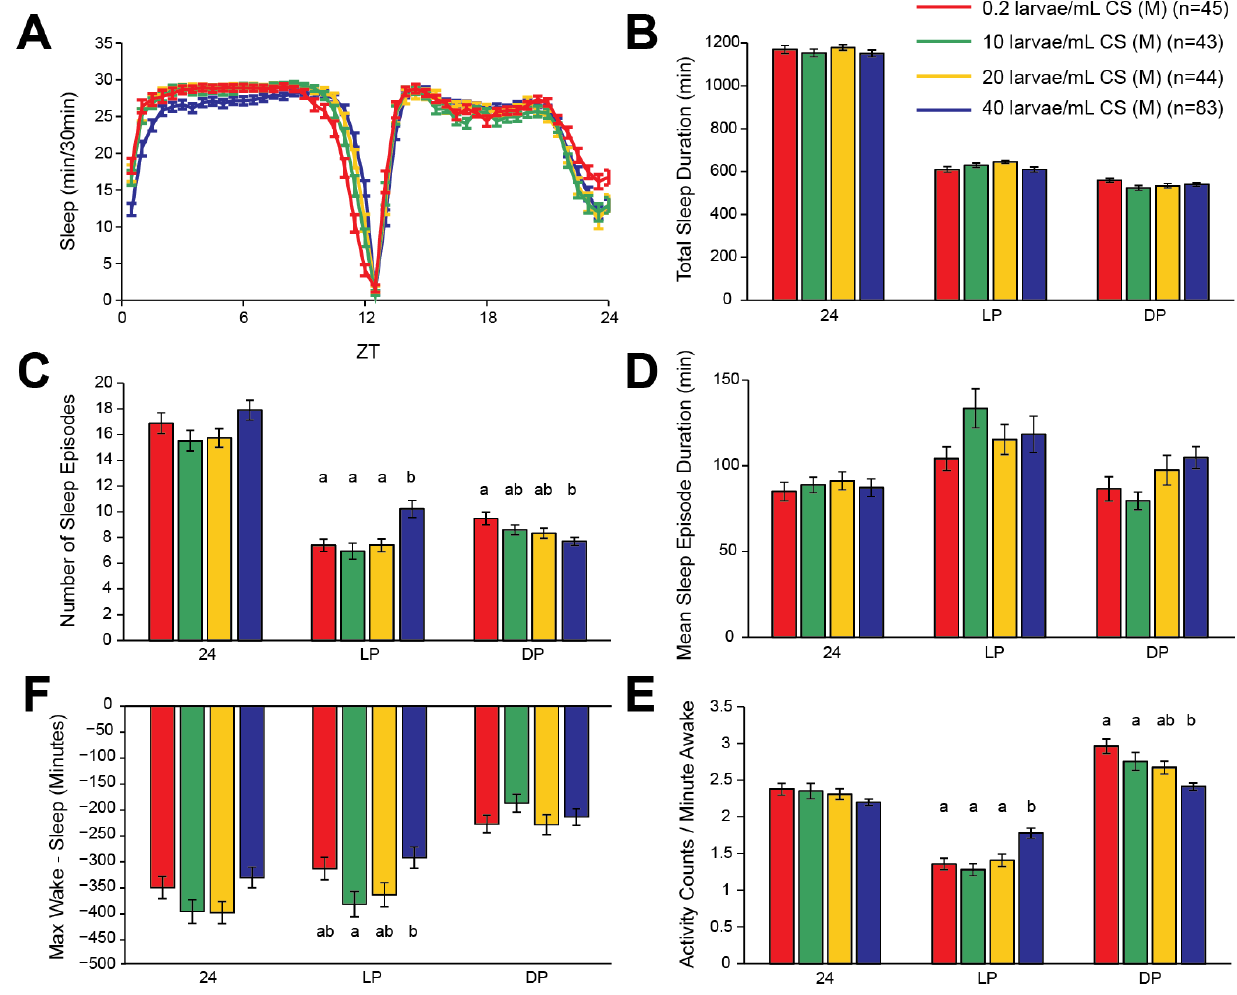
Figure 2. Increasing larval population density has modest effects on sleep characteristics in adult male fruit flies. ( A ) Minutes of sleep per 30-min bin, across an average day consisting of 12 h of light followed by 12 h of darkness (LD). Time after lights-on is indicated by zeitgeber time (ZT) on the X -axis. ( B – F ) Quantification of sleep parameters for the same average LD day, across all 24 h, across the light period (LP), or across the dark period (DP). Error bars represent the standard error of the mean. n represents the number of flies in each group. Letters above columns are present in cases where a significant effect of population density was observed, and indicate significance groups from post-hoc analysis. Columns within each group of four that do not have any letter in common are significantly different from each other. ( B ) Total sleep duration. ( C ) Number of sleep episodes. ( D ) Mean sleep episode duration. ( E ) A metric for relative stability of wake and sleep states, calculated by subtracting the duration of the longest sleep episode from the duration of the longest wake episode. Thus, positive values indicate that wakefulness was more consolidated than sleep, and vice versa . ( F ) Total number of beam crosses, or activity counts, per minute of wakefulness. There were no significant effects of larval population density in male flies across the